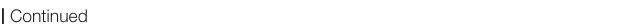
FIGURE 6 | Continued migration distances of individual GCs between groups: controls ( n = 15 slices; 183 cells), normal mouse IgG ( n = 2 slices, 38 cells) and CR-50 ( n = 10; 254 cells). Under control conditions and with normal mouse IgG, GCs do not change position. In contrast, incubation with the CR-50 antibody strongly induces migratory behavior as indicated by strongly increased effective distances. (E) Diagram showing the directionality ratio. All three groups show similar values. (F) Graph showing the path of one representative neuron after incubation with the CR-50 antibody. Cell motility was assessed by calculating both the total length of the traveled path over 8 h (black dashed line = total distance) and the effective distance of the migration as the length of the resulting vector (green solid line) between start ( t = 0 h) and end point ( t = 8 h). Note that the path of this neuron is straight without any changes in direction. (G) Graph showing that there is no correlation between effective migration distance and start distance from the hilus of tracked GCs. All cells change their positions and travel regardless of their position in the GCL. (H) Relative distribution of cells traveling toward the hilus (51.2%) or molecular layer (48.8%) in OHSC incubated with CR-50 antibody. To differentiate the migration direction, the border between the hilus and GCL was marked and the distance of the start and end point of the cells to this border was calculated Cells that reduce their distance to the border over time [H distance ( t = 0 h) – H distance ( t = 8 h), positive values] are considered migrating toward the hilus. Cells showing an increase in distance (negative values) moved toward the ML. One-way ANOVA, followed by Tukey’s Multiple Comparison Test (*** P < 0.001; Ctrl vs. Normal IgG show no significance). Scale bars: 80 µ m for overview; 10 µ m for high magnifications. (I) Representative GC from an OHSC treated with CR-50 and imaged over a period of 8 h, as described above. Note the change in the soma shape as the neuron shifts position (white arrow heads), the soma moves into an apical dendrite (magenta arrows). Scale bar: 5 µ m. GCL, granule cell layer; H,